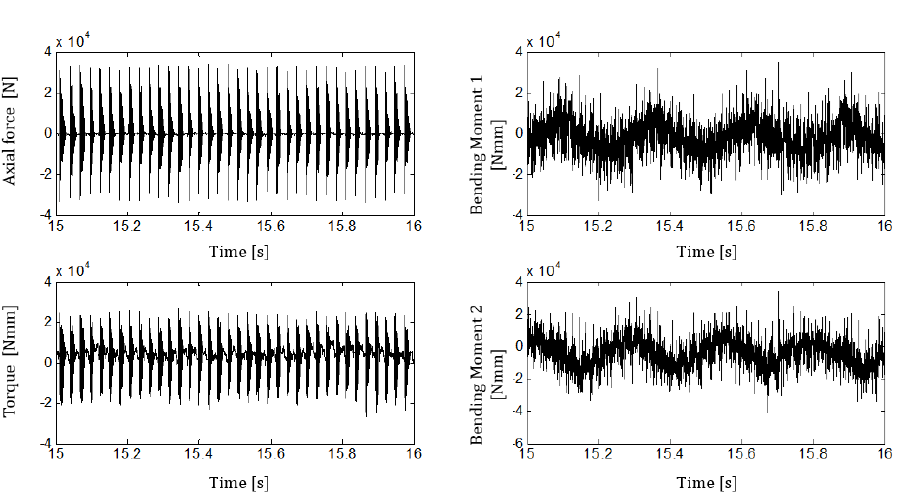
Figure 7. Measured time histories for the hammer displacement and the operator’s weight, test case IDN 020.